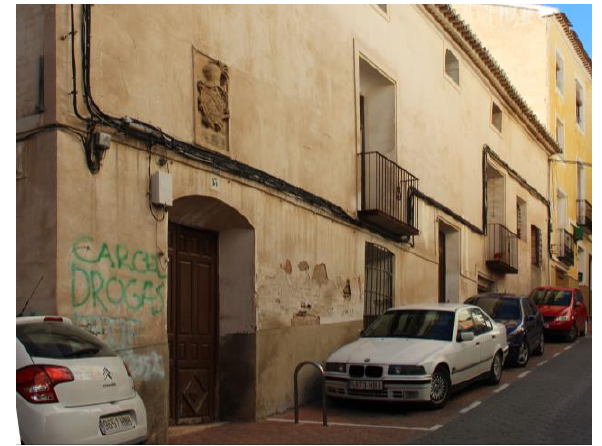
Figure 4. 16th-century palace in Mula (Source: